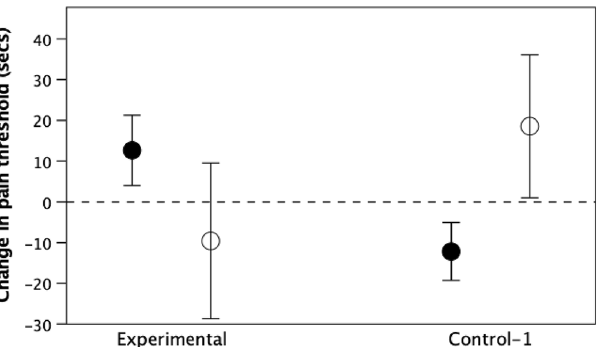
Figure 1. Mean (± 1 se) change in absolute pain threshold following the music task. Filled symbols: subjects who complied with the instructions they were given (nodding their head in the experimental condition, remaining still in the control condition); unfilled symbols: subjects who failed to follow instructions (failed to head-nod in the experimental condition or head-nodded in the control condition). Sample size (L to R): 14, 6, 19, 2.